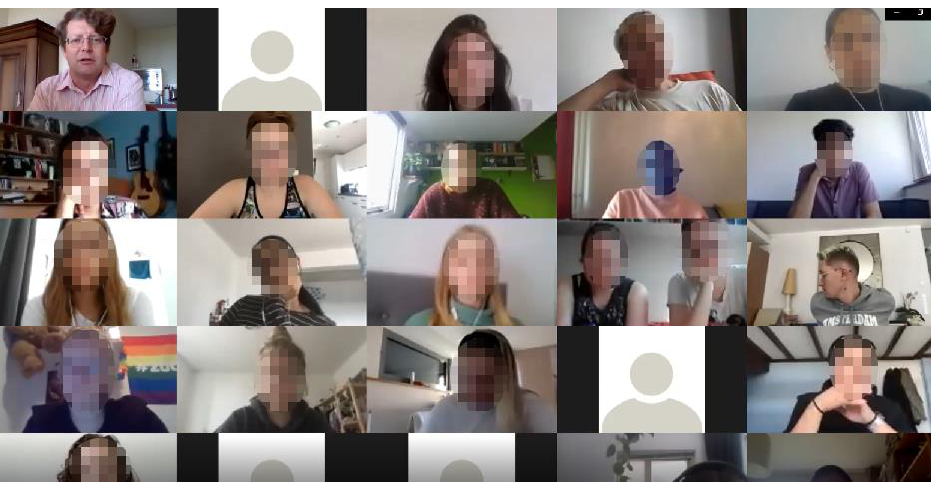
Figure 5. Visual representation of participant behaviors 5.